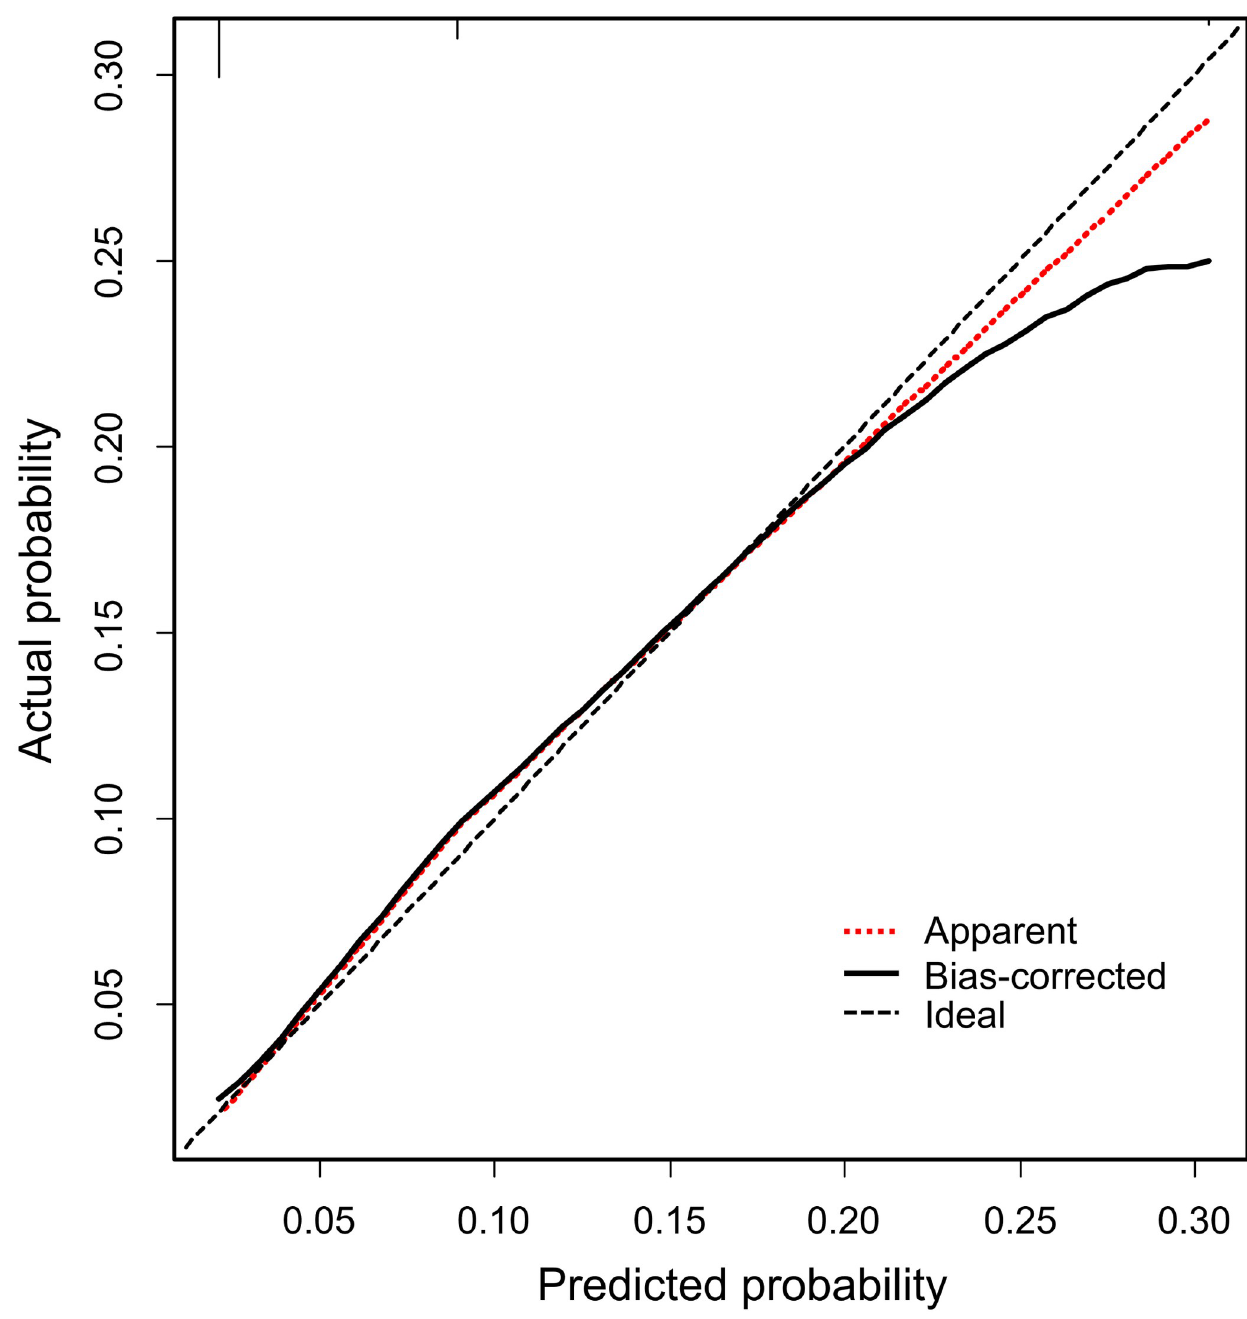
Fig 4. Calibration curve with bootstrap resampling validation for predicting the risk of hospitalization. by September 2021. The number of vaccinated patients who were admitted to a designated hotel between August 2020 and September 2021 was very small in the present cohort, presum- ably because of the low vaccination rate and the high effectiveness of vaccination in the youn- ger population.